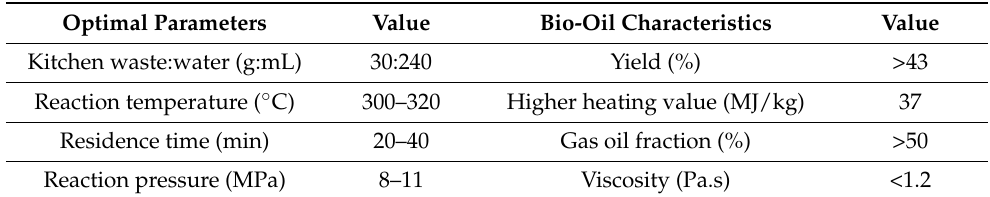
Table 5. Optimal parameters of bio-oil production from kitchen waste by hydrothermal reaction and characteristics of bio-oil